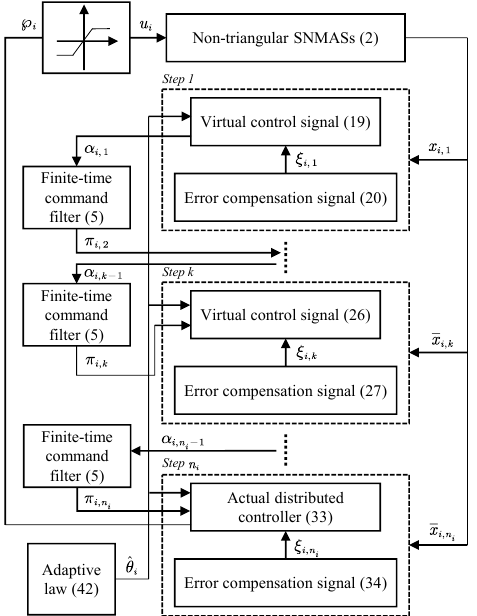
Figure 1. A block diagram of the finite-time distributed consensus control design